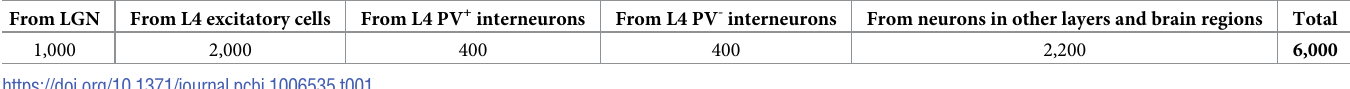
Table 1. Assumed average numbers of synapses per an excitatory cell in L4 of mouse V1. See text for details. From LGN From L4 excitatory cells From L4 PV + interneurons From L4 PV - interneurons From neurons in other layers and brain regions